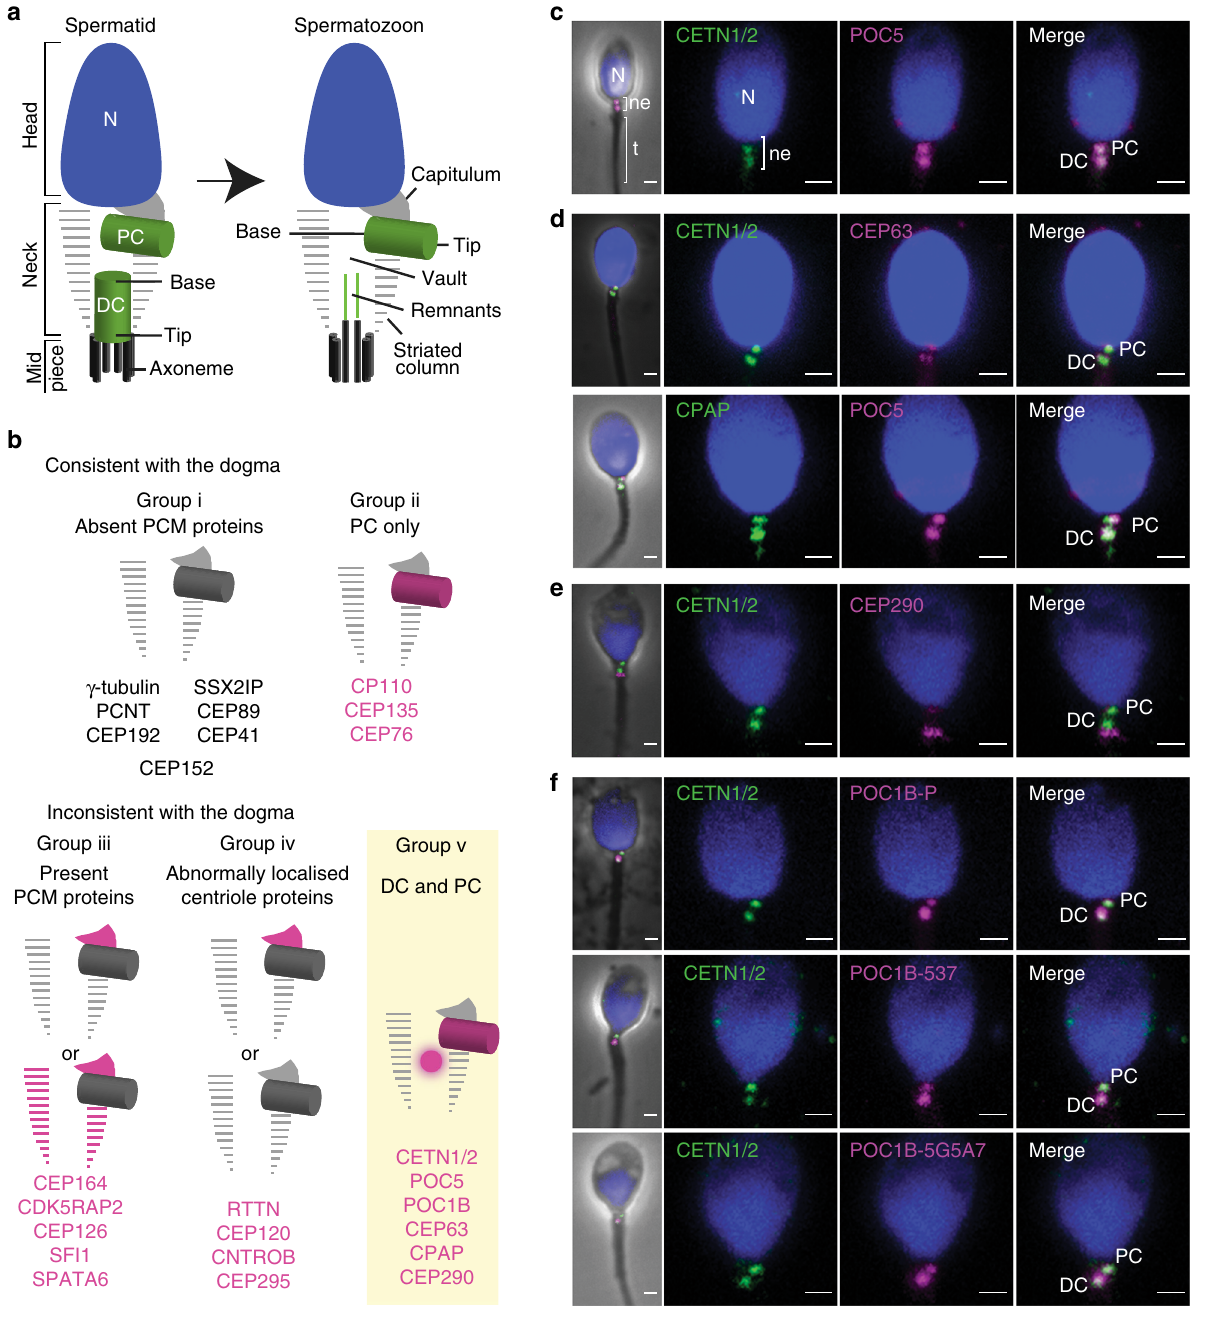
Fig. 1 Centriolar proteins localize to the DC (group v). a The current dogma is that mature sperm have one centriole. The spermatid neck has a PC and DC, and the ejaculated spermatozoon has a PC and an empty space, the vault, which marks the location of the degenerated DC (Manandhar et al. 6 ). b Graphical summary of the groups of the localization patterns of proteins in the sperm. Group i is centriolar proteins that were localized to the PC area only and is consistent with the dogma. Group ii is PCM proteins that were absent from the sperm, as is consistent with the dogma. Group iii are PCM proteins that were unexpectedly localized to the striated columns or capitulum. Group iv are centriolar proteins that were unexpectedly localized to the striated columns or capitulum, or were unexpectedly absent altogether. Group v are proteins that were unexpectedly present in the DC and the PC, which are inconsistent with the dogma. Group v is shown in c – f . c Antibodies against the centriole tip proteins CETN1/2 and POC5 labeled the PC and DC. d Antibodies against CEP63 and CPAP labeled near the CETN1/2 or POC5-labeled PC and DC. e Antibodies against CEP290 labeled adjacent to the CETN1/ 2-labeled DC, presumably marking the junction of the DC with the axoneme. f Three distinct antibodies against POC1B labeled both the PC and DC. Unlike other centriolar proteins, POC1B was enriched in the DC relative to the PC (POC1B-P: 2.1 ± 0.5, POC1B-537: 2.74 ± 1.64, POC1B-5G5A7: 1.92 ± 0.41, N > 6). POC1B-P, Rabbit polyclonal antibody from the Pearson lab; POC1B-537, Rabbit polyclonal antibody from the Avidor-Reiss lab; POC1B-5G5A7 Rat monoclonal Ab from the Avidor-Reiss lab. N nucleus, ne sperm neck, t tail; scale bars 1 μ